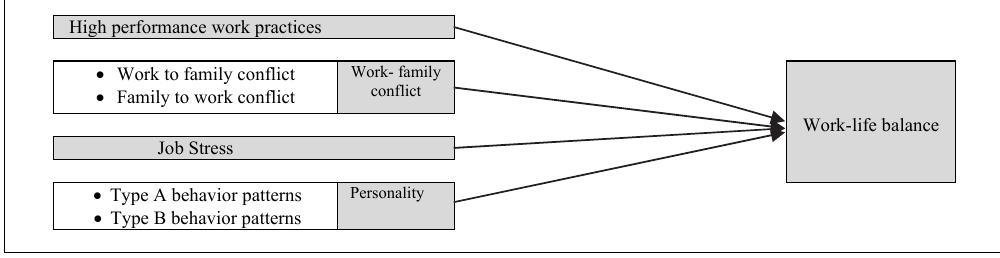
Fig. 1. The proposed